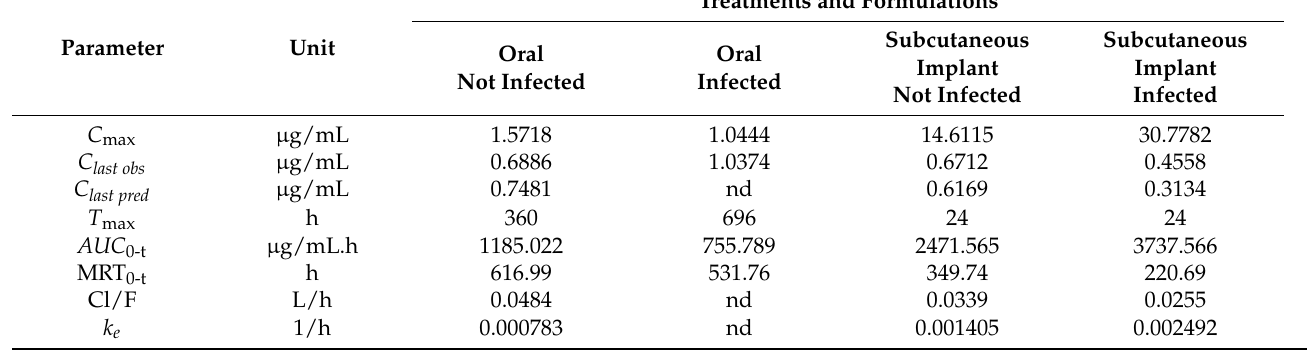
Table 4. Pharmacokinetic parameters of oral and subcutaneous (implant) administration of benznida- zole during treatment with the same total dose (100 mg/animal) in healthy and in T. cruzi - infected